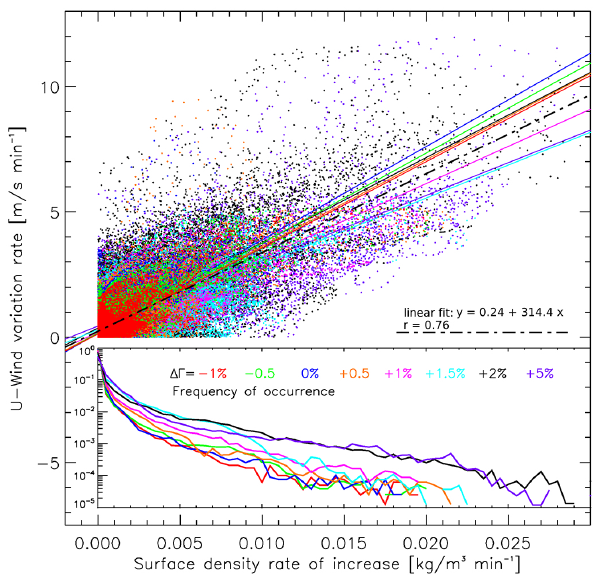
Fig. 5. Top image: absolute variation rate of U -wind component [ms − 1 min − 1 ], plotted as a function of surface density rate of in- crease [kgm − 3 min − 1 ], for the eight environmental potential tem- perature lapse rate increments 10 (all other variables remaining constant), reported in the figure with the same colors for data points as their corresponding experiments. U and ρ variations are calcu- lated for each 10s time step, as the absolute difference between their value at a certain instant and that 1min (i.e., six time steps) be- fore, and occurring within a radius of 45km from domain center and t > 40min. The calculated linear fit of the whole data set (522450 points) is reported, together with the estimate of linear regression coefficient, r = 0 . 76. Inset bottom image: frequency of occurrence, from 0 to 1, of surface density rate of increase. Horizontal scales of top and bottom image